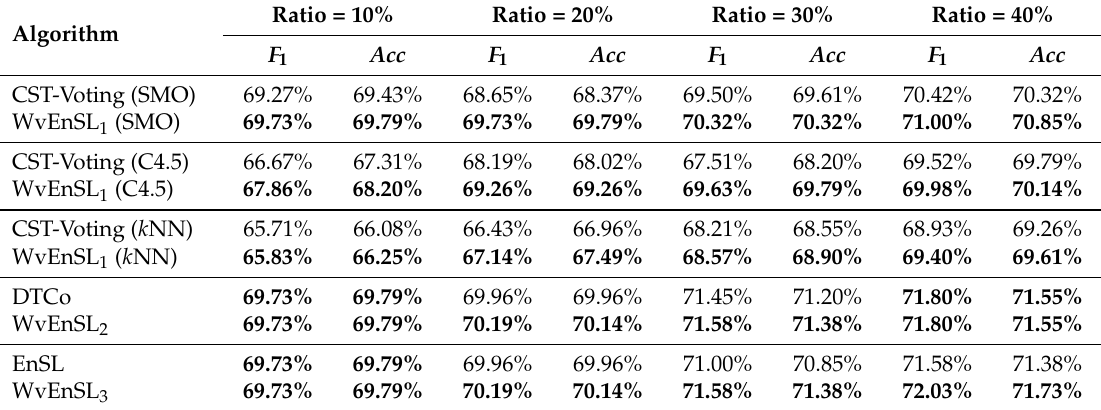
Table 3. Performance evaluation of WvEnSL against ensemble self-labeled algorithms for Tuberculosis dataset.